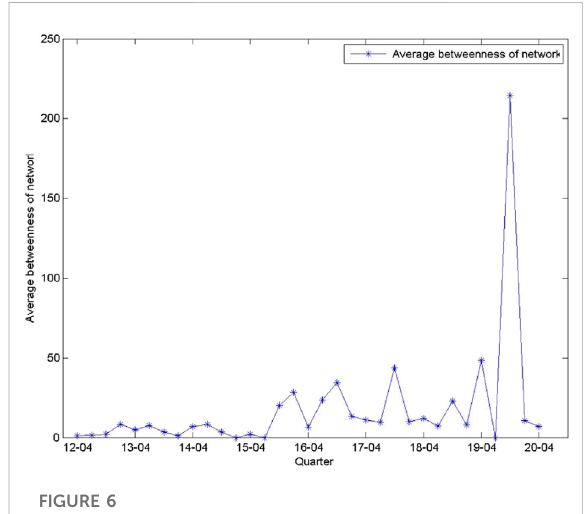
FIGURE 7 Quarterly change of average H-index of China ’ s auto fi nance market network from 2012 to